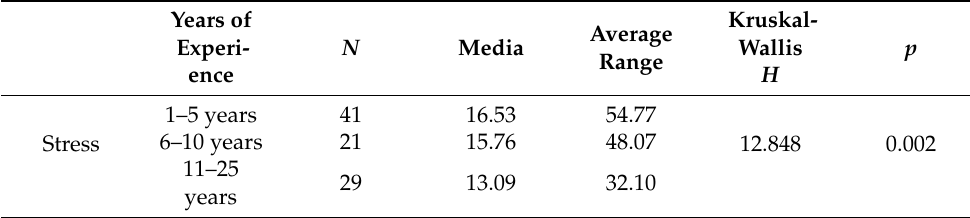
Figure A4. Comparison between pairs of the Psychological Distress in Non-Formal Contexts scale as a function of the variable basketball qualifications. Table A3. Years of experience and level of Psychological Distress in Non-Formal